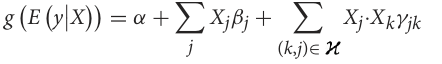
Accordingly, either the next set of modifications is identified, or the previous model is declared